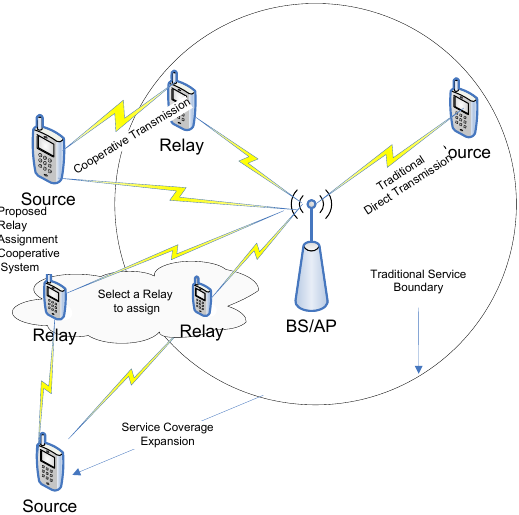
Figure 6. Coverage extension and relay selection (from work in